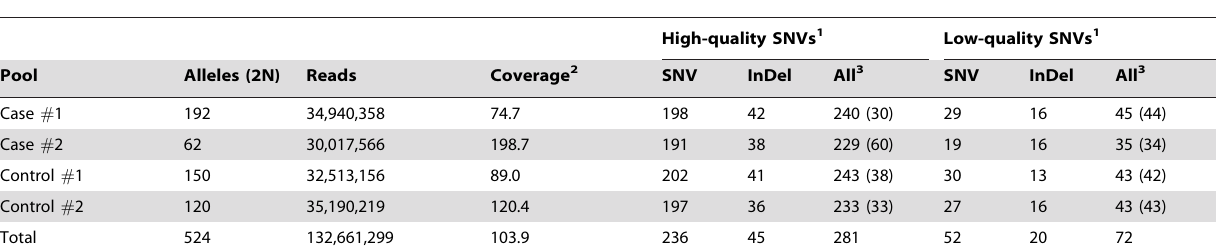
Table 1. Summary statistics of sequencing and identified genetic variants.